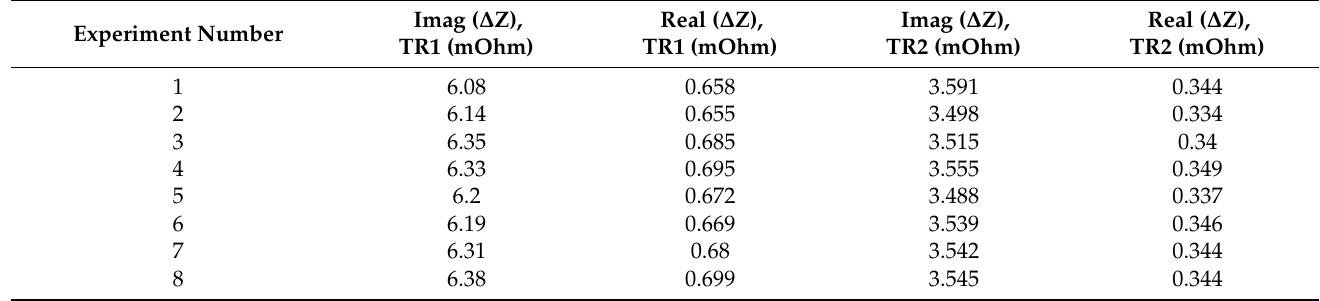
Table A3. Raw data of impedance change, cylindrical zinc metal at a lift-off of 5